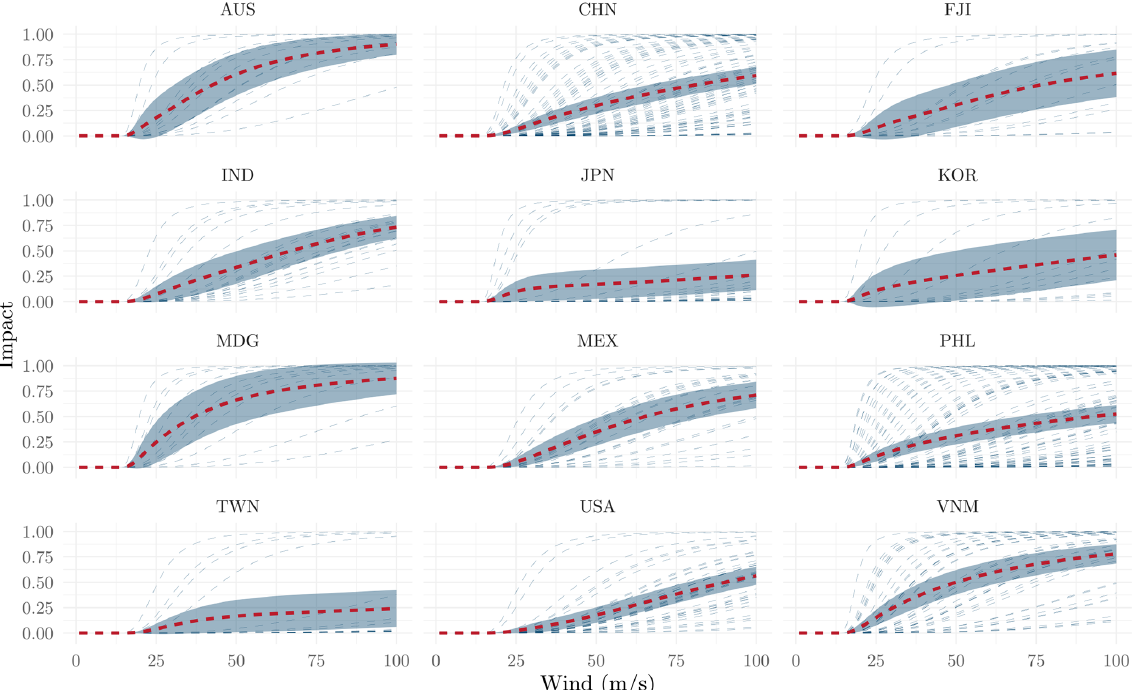
Figure A5. Country calibration of damage functions (when the countries have been hit more than five times).